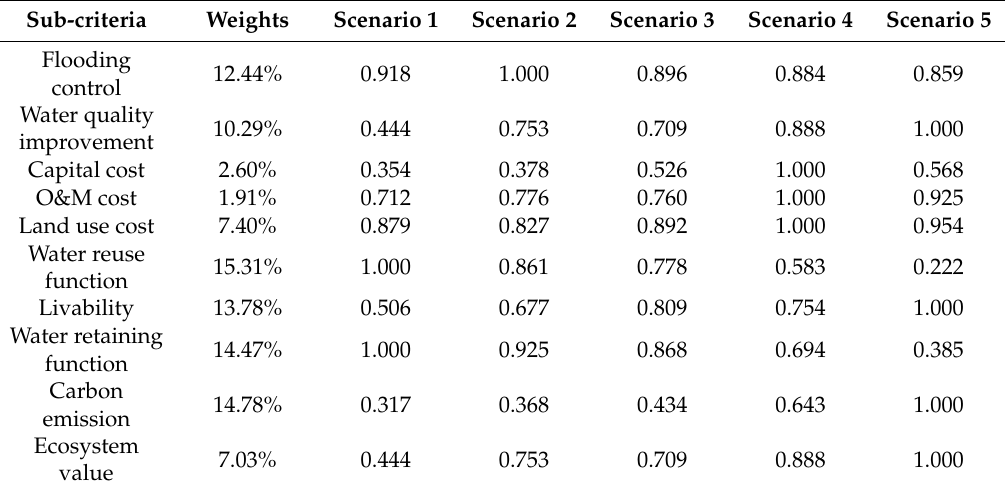
Table A13. The normalized values of each scenario as well as its weight.